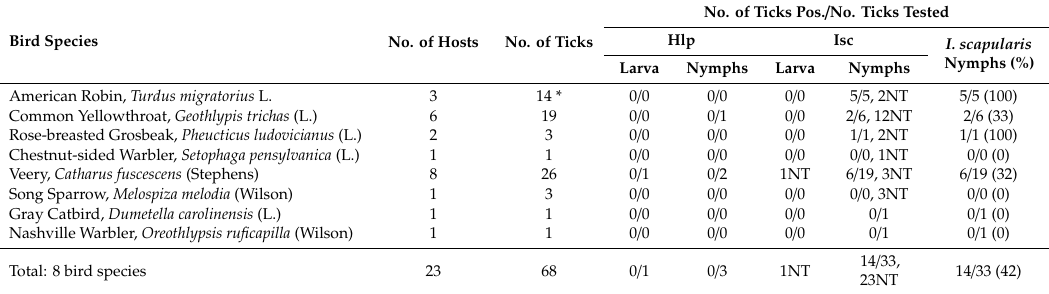
Table 1. Detection of Borrelia burgdorferi sensu stricto in ticks collected from nesting songbirds captured at Mont é e Biggar, Qu é bec, 8th June to 2nd August 2019.